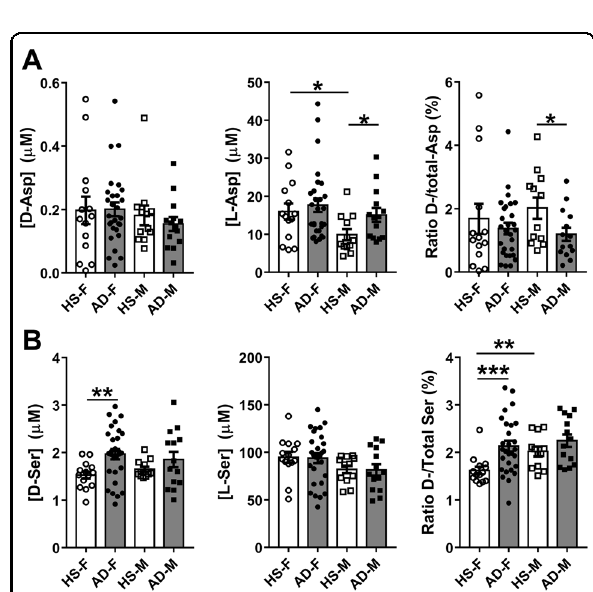
Fig. 2 Gender related variations of aspartate and serine enantiomer levels in human serum. D - and L -Asp ( A , left and center, respectively) and D - and L -Ser ( B , left and center, respectively) levels and ratio between D -enantiomer and total ( D + L ) amino acid content ( A right and B right for Asp and Ser, respectively, expressed as percentage) detected in serum samples of AD patients compared to healthy subjects (HS). Dots and bars represent the single subjects ’ values and the standard error of the mean, respectively. * P <0.05; ** P <0.01; *** P < 0.001 (Mann – Whitney unpaired test). F female, M male.